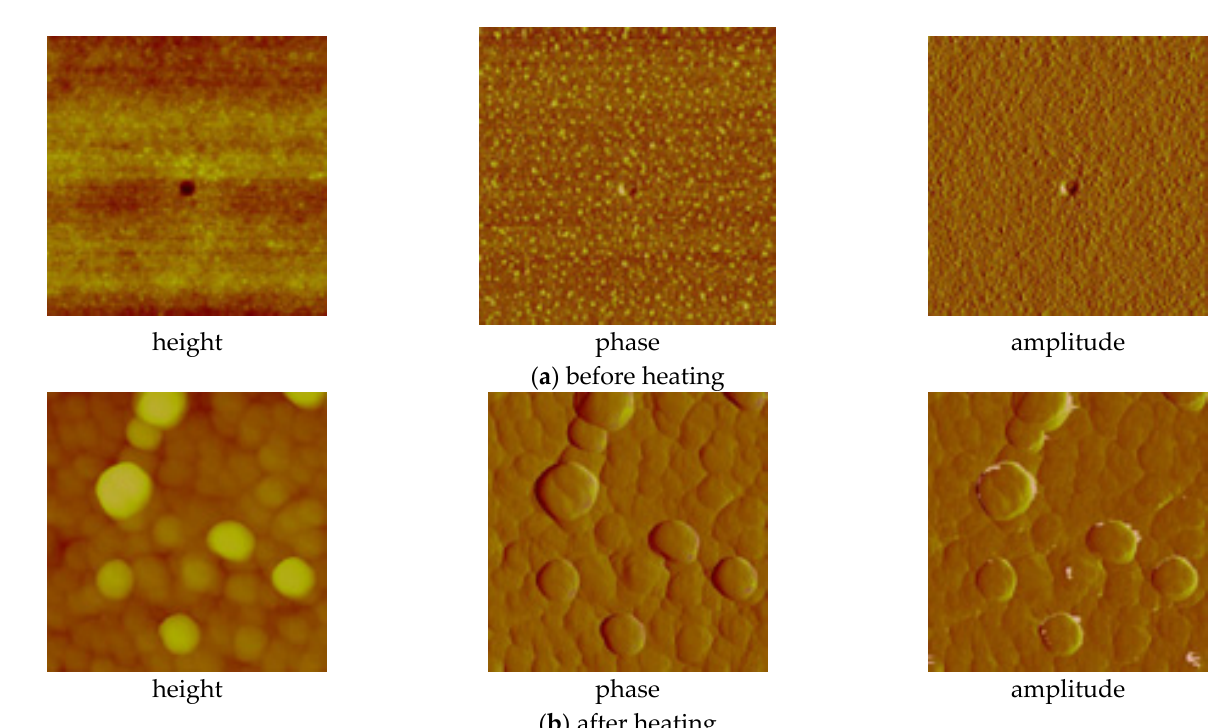
Figure 14. AFM images of [Cu 2 (EtNH 2 ) 2 (µ-O 2 CC 3 F 7 ) 4 ] ( 3 )/Si ( a ) before, ( b ) after heating (1100 rpm, 30 s). The application of the [Cu 2 (EtNH 2 ) 2 (µ-O 2 CC 2 F 5 ) 4 ] complex ( 2 ) on Si(111) in the